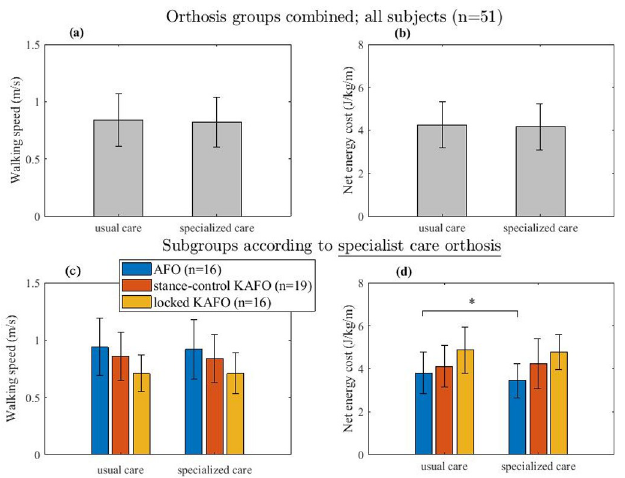
Fig 3. Bar plots of walking speed (m/s) and net energy cost (in J/kg/m) for the usual care orthoses and specialist care orthoses, respectively for all orthosis groups combined (upper panels A and B) and for subgroups of subjects provided with specialist care ankle-foot orthoses (AFOs), stance-control knee-ankle-foot orthoses (SC-KAFOs) and locked knee-ankle-foot orthoses (KAFOs) (lower panels C and D). Note that orthoses were categorized based on the provided specialist care orthoses, thus the usual care orthoses in panels C and D do not necessarily represent the same orthosis types. In all plots, error bars represent the standard deviation.